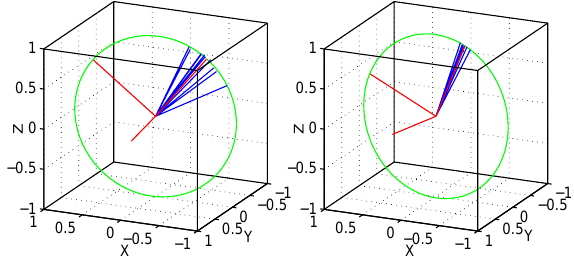
Fig. 4. The MTA analysis on the flux rope event during 11:10:24 UT to 11:10:52 UT. In the left box, the magnetic strength is selected as the signal, while in the right one, the B N component is selected. In either of the boxes, the blue lines show the normal directions obtained by the Triangulation method as the first step of MTA, and the red lines are the three eigenvectors of the corresponding matrix. The green circle represents the cross-section plane of the flux rope, basically containing all of the blue lines, while the red line which is perpendicular to the green circle suggests the flux rope orientation.